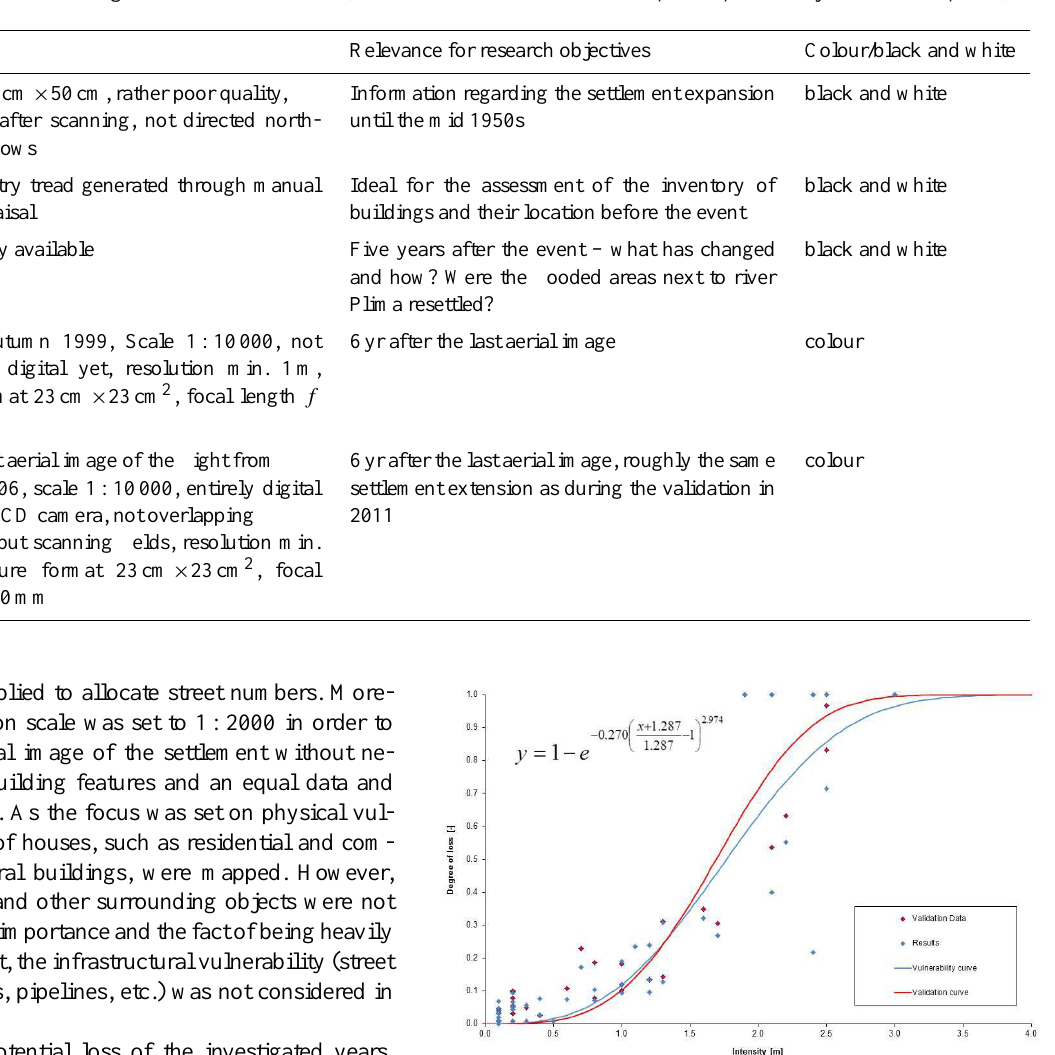
additionally aerial photos were used to locate the